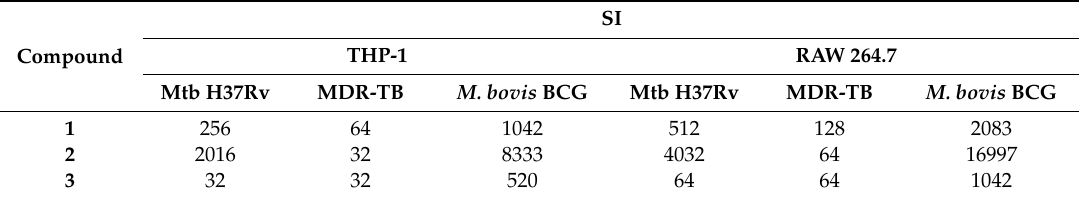
Table 2. Selectivity indices of the derivatives (cell line vs.